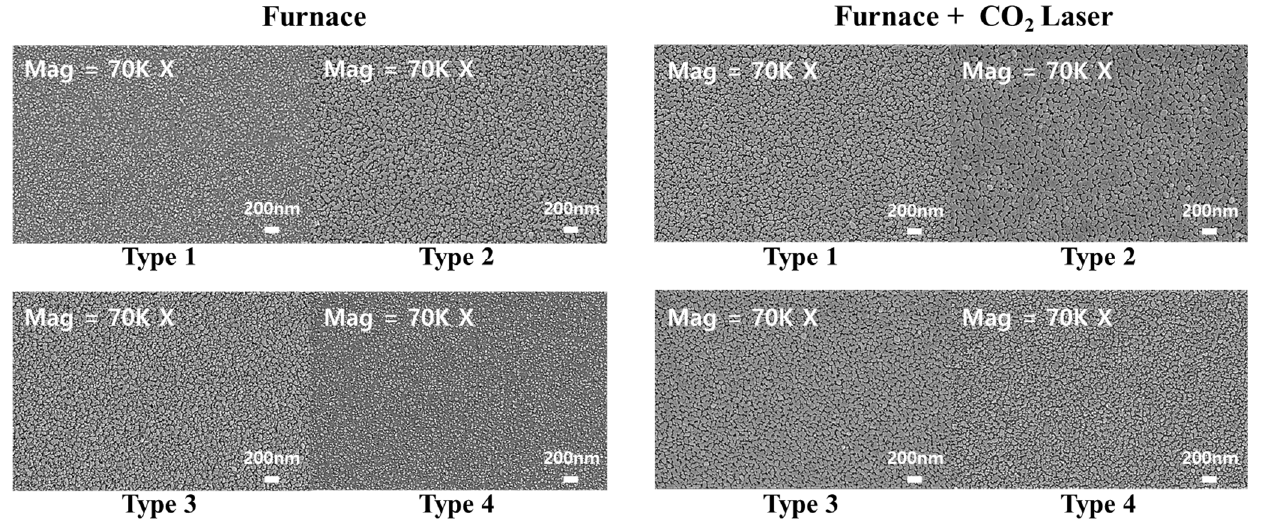
Figure 4. FE-SEM surface images of 4 types of (In, Ga) co-doped ZnO multilayered thin films after electrical furnace and furnace & CO 2 laser annealing. Acceleration voltage: 5.00 kV; magnification: Table 2. Grain size and grain size difference of (In, Ga) co-doped multilayered thin films with the 2 different annealing processes; F: electrical furnace annealing, FL: electrical furnace + carbon-dioxide laser annealing.